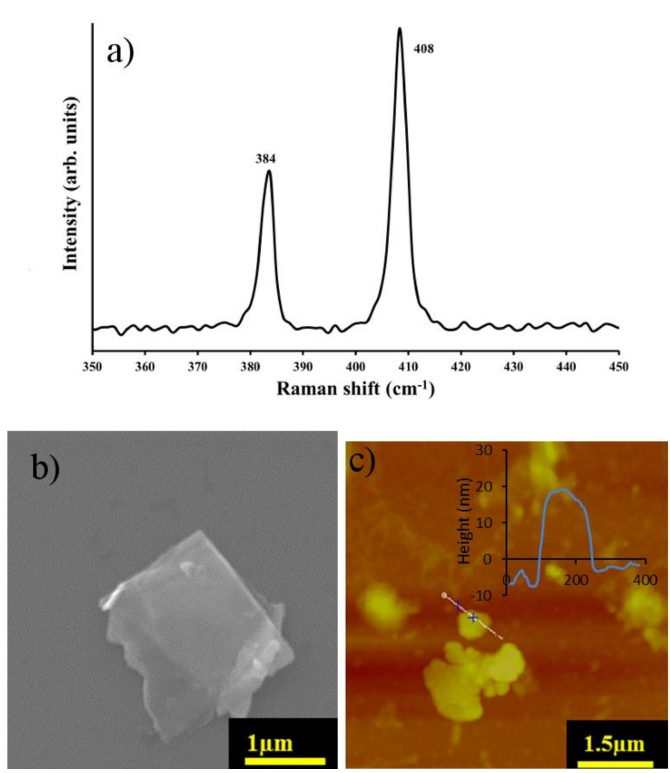
Figure 2. ( a ) Raman spectrum (collected using the 1800 grooves/mm grating); ( b ) Scanning electron microscopy (SEM) image and ( c ) Atomic Force Microscopy (AFM) image of MoS 2 film deposited on a Si substrate and the corresponding line scan of the MoS 2 -nanosheet